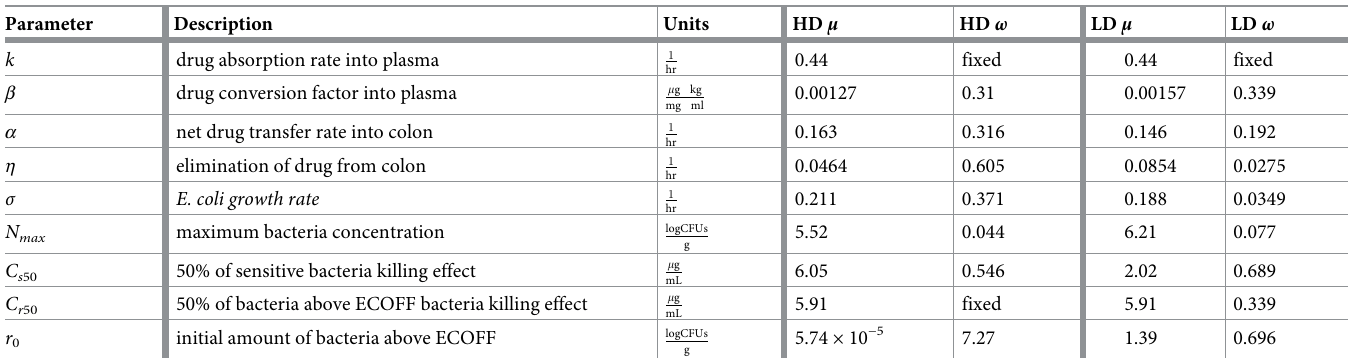
Table 1. Parameter